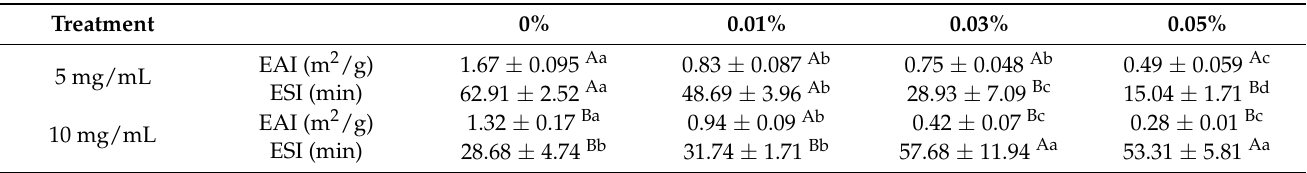
Table 3. Effects of TPP on EAI and ESI of MP O/W